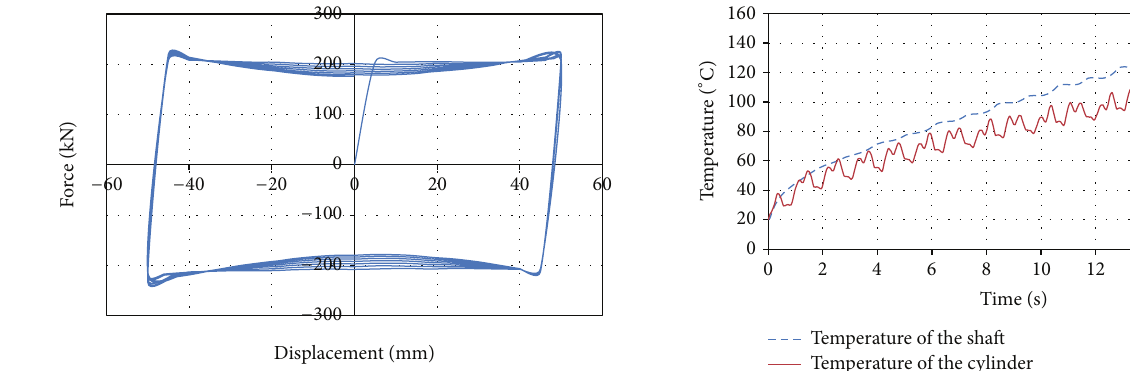
Figure 15: Comparison between temperatures of the shaft and cylinder for improved CFD (7 cycles and frequency = 0.45